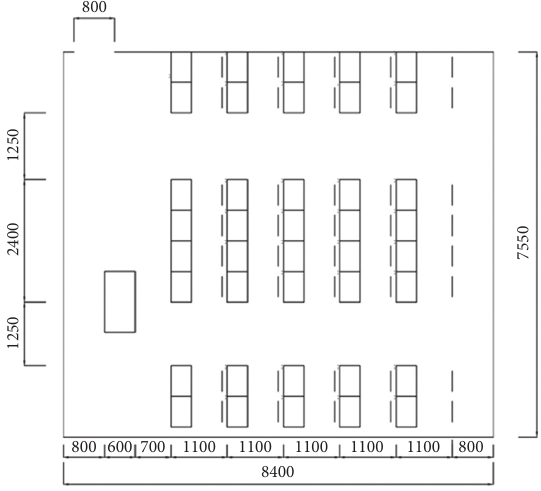
Figure 4: Initial building layout.